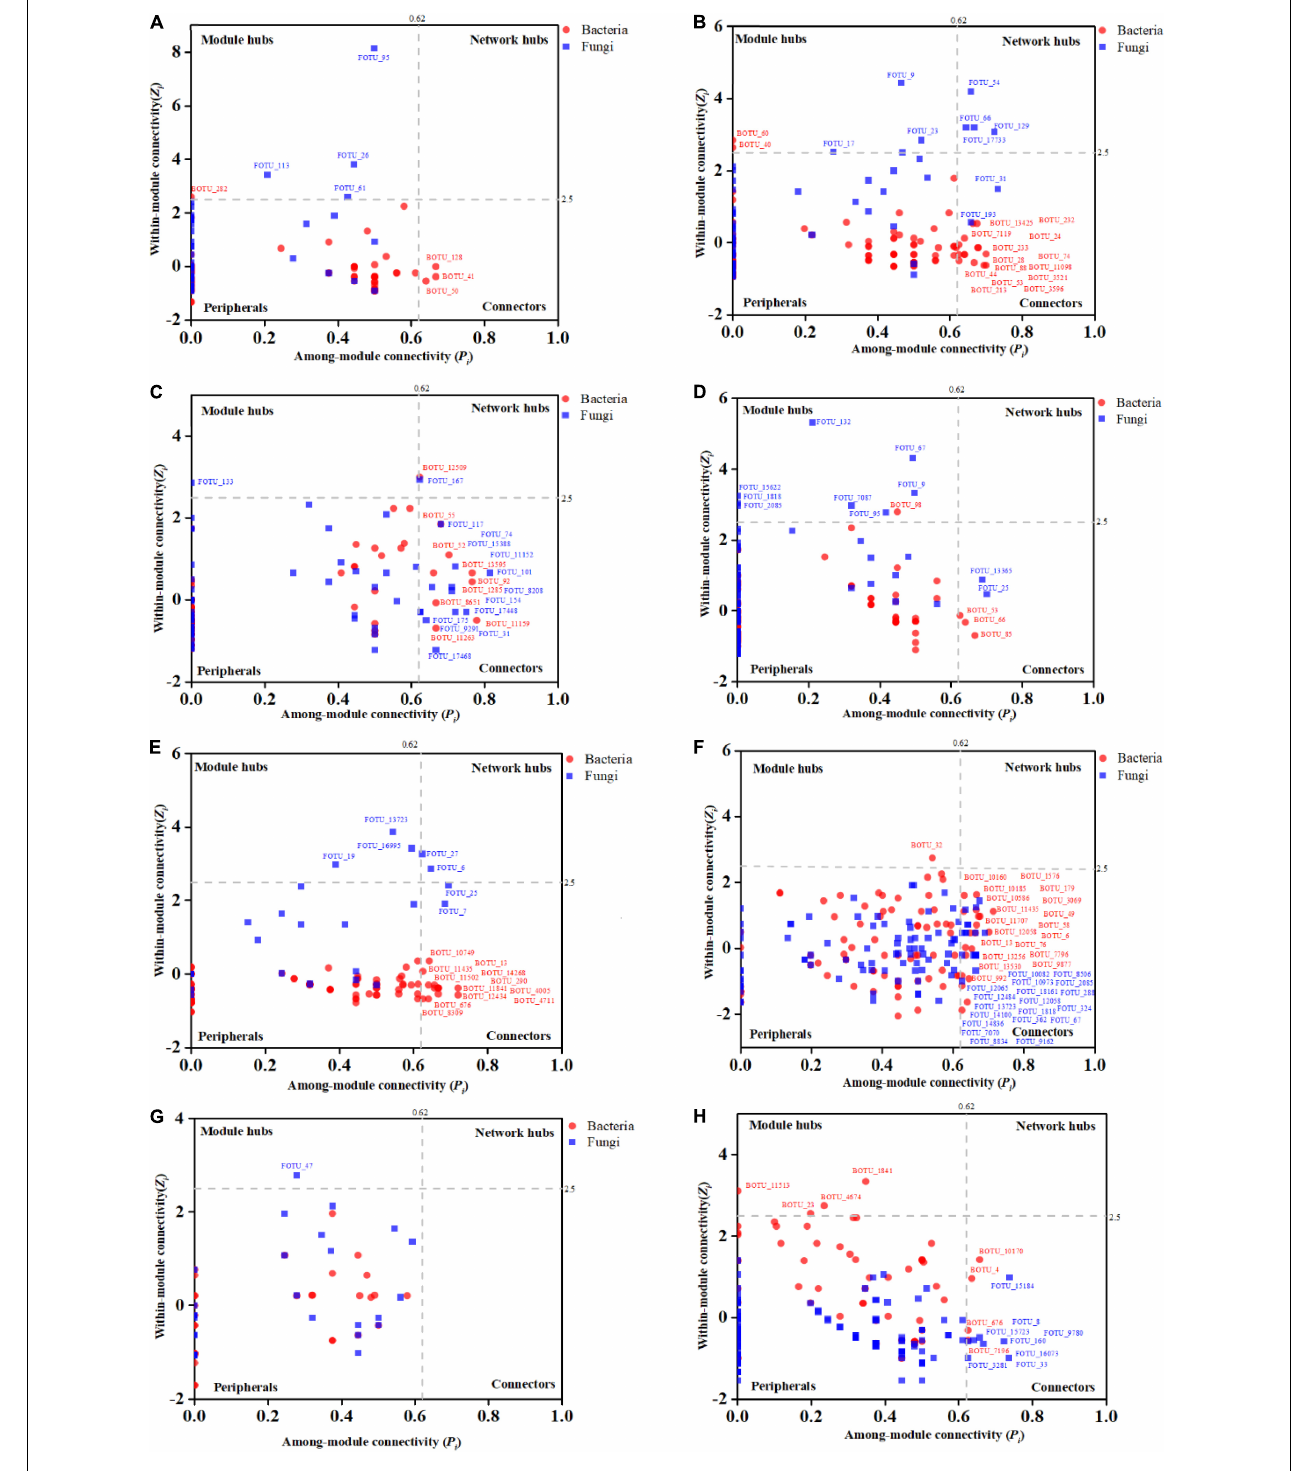
FIGURE 5 | The Zi-Pi plots exhibit the distributions of OTUs based on their topology. The symbols represent OTUs in the bacterial (red dots) and fungal (blue squares) networks. The threshold values of Zi and Pi for categorizing OTUs are 2.5 and 0.62, respectively. (A) Healthy bulk soil. (B) Infected bulk soil. (C) Healthy rhizosphere soil. (D) Infected rhizosphere soil. (E) Healthy root endophytic compartment. (F) Infected root endophytic compartment. (G) Healthy stem endophytic compartment; (H) Infected stem endophytic compartment.